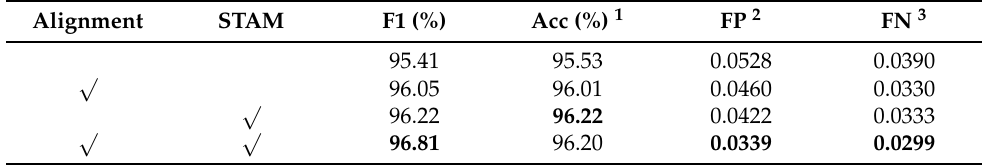
Table 2. Experimental results for the designed components. The number of input frames is set 4. Alignment STAM